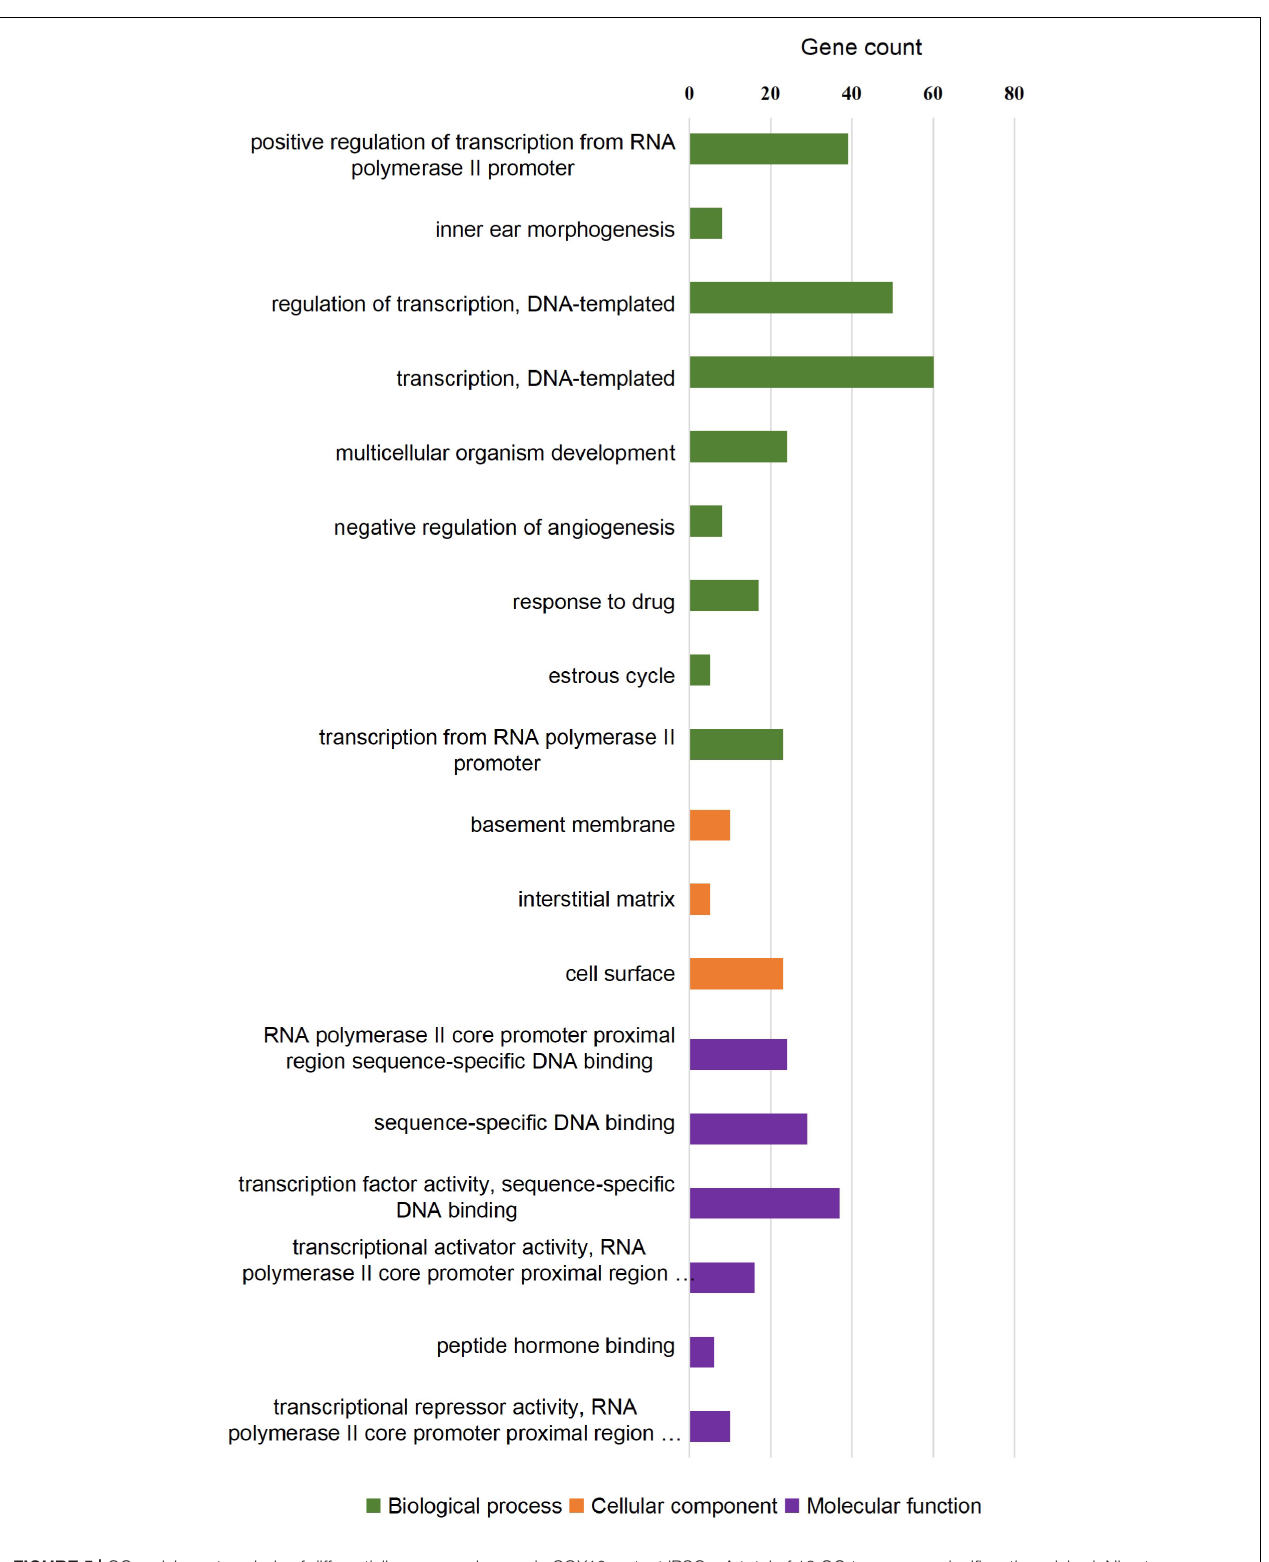
FIGURE 5 | GO enrichment analysis of differentially expressed genes in SOX10 mutant iPSCs. A total of 18 GO terms were significantly enriched. Nine terms were significantly enriched based on biological process, three terms were significantly enriched based on cellular components, and six terms were significantly enriched based on molecular